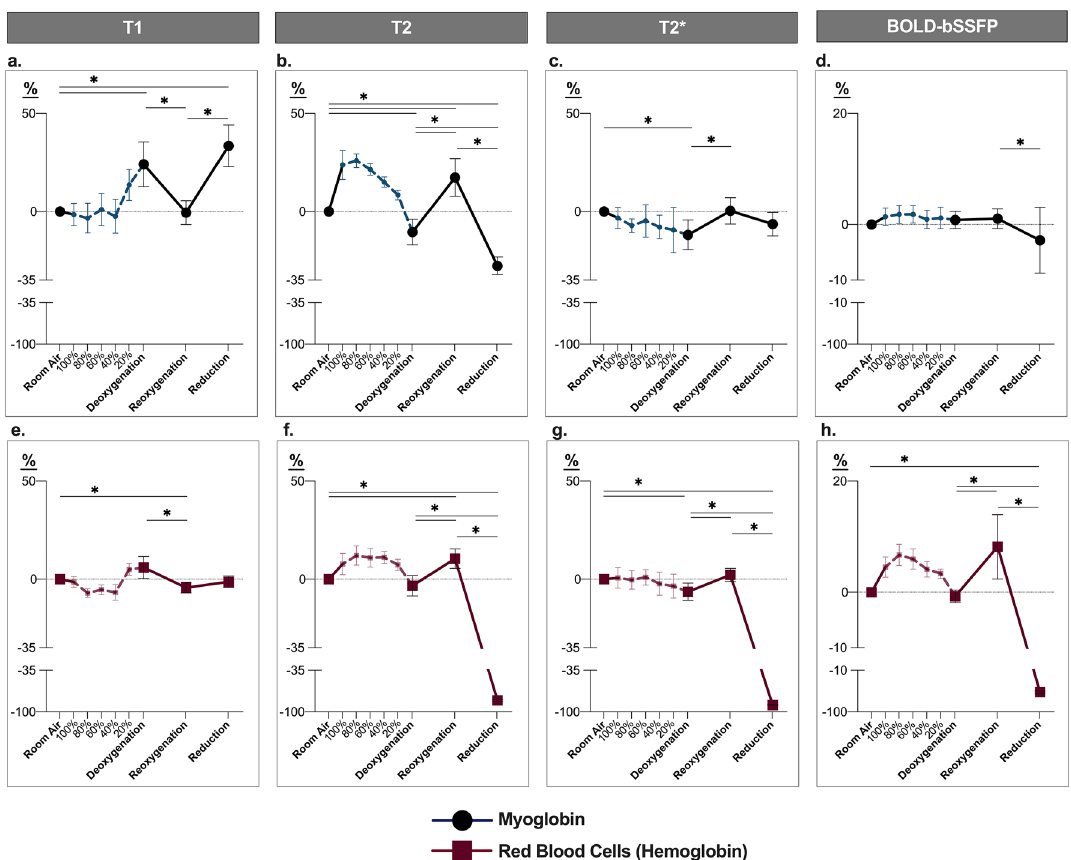
Figure 2. MRI detects the changing oxygenation of myoglobin and hemoglobin: Mean ± 95% confidence intervals of the percent-change from the room air level are shown for each oxygenation state when measured with a T1 map ( a , e ), a T2 map ( b , f ), a T2* map ( c , g ) and a blood oxygen level-dependent balanced steady-state free precession image (BOLD-bSSFP; d , h ). The responses for isolated myoglobin are shown in the top row and red blood cells representing the response of hemoglobin in the bottom row. Dotted lines depict the stepwise de-oxygenation process from 100% O 2 /0% N 2 to a mix of 0% O 2 /100% N 2 in 20% increments. A break is present in the negative values of the y-axis to depict the significant reduction by chemical reduction in the same figure. Image prepared using Graphpad Prism v 8.0 (www. graph pad. com). * p < 0.05 represents a significant difference in signal between major oxygenation